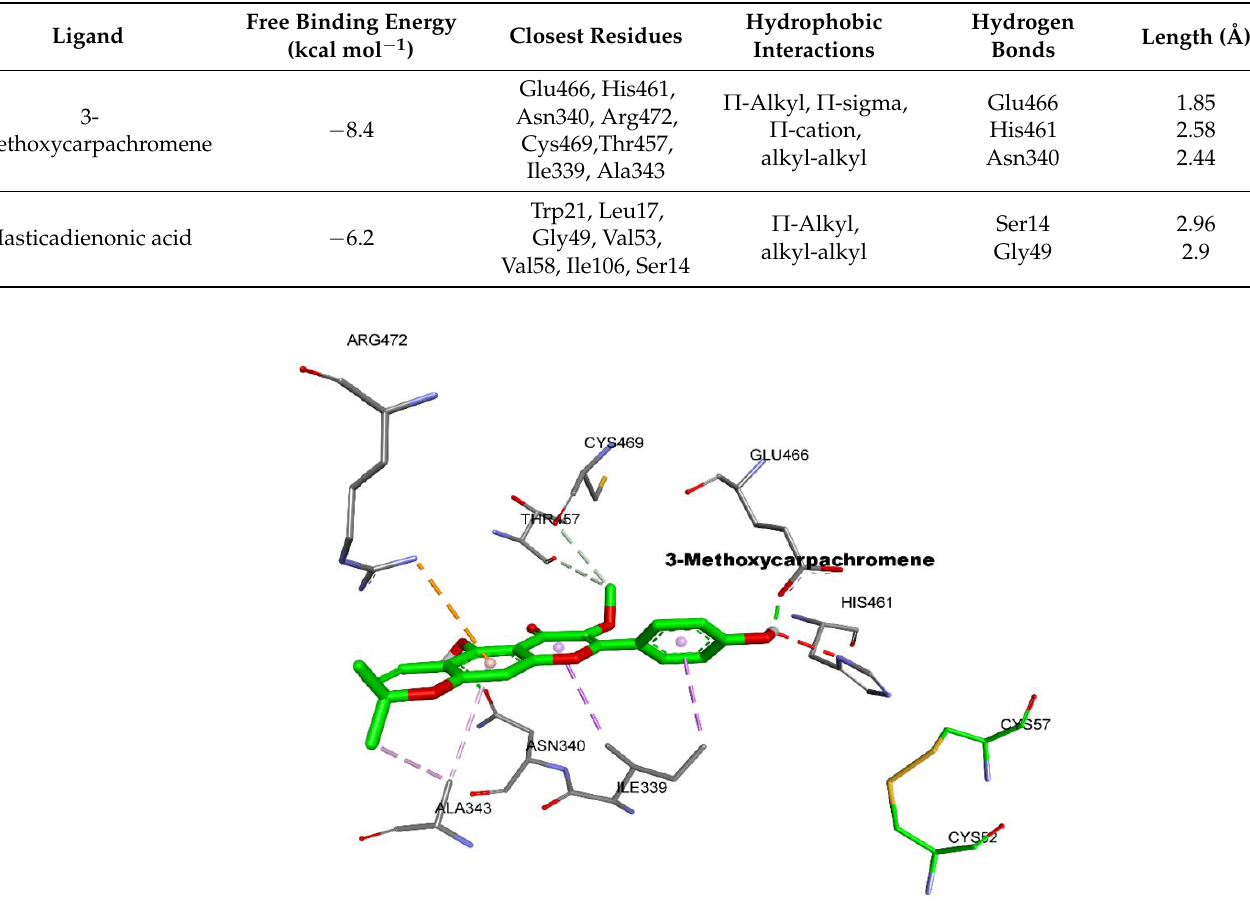
Figure 1. Best pose of docking for 3-Methoxycarpachromene in the catalytic site of trypanothione reductase.